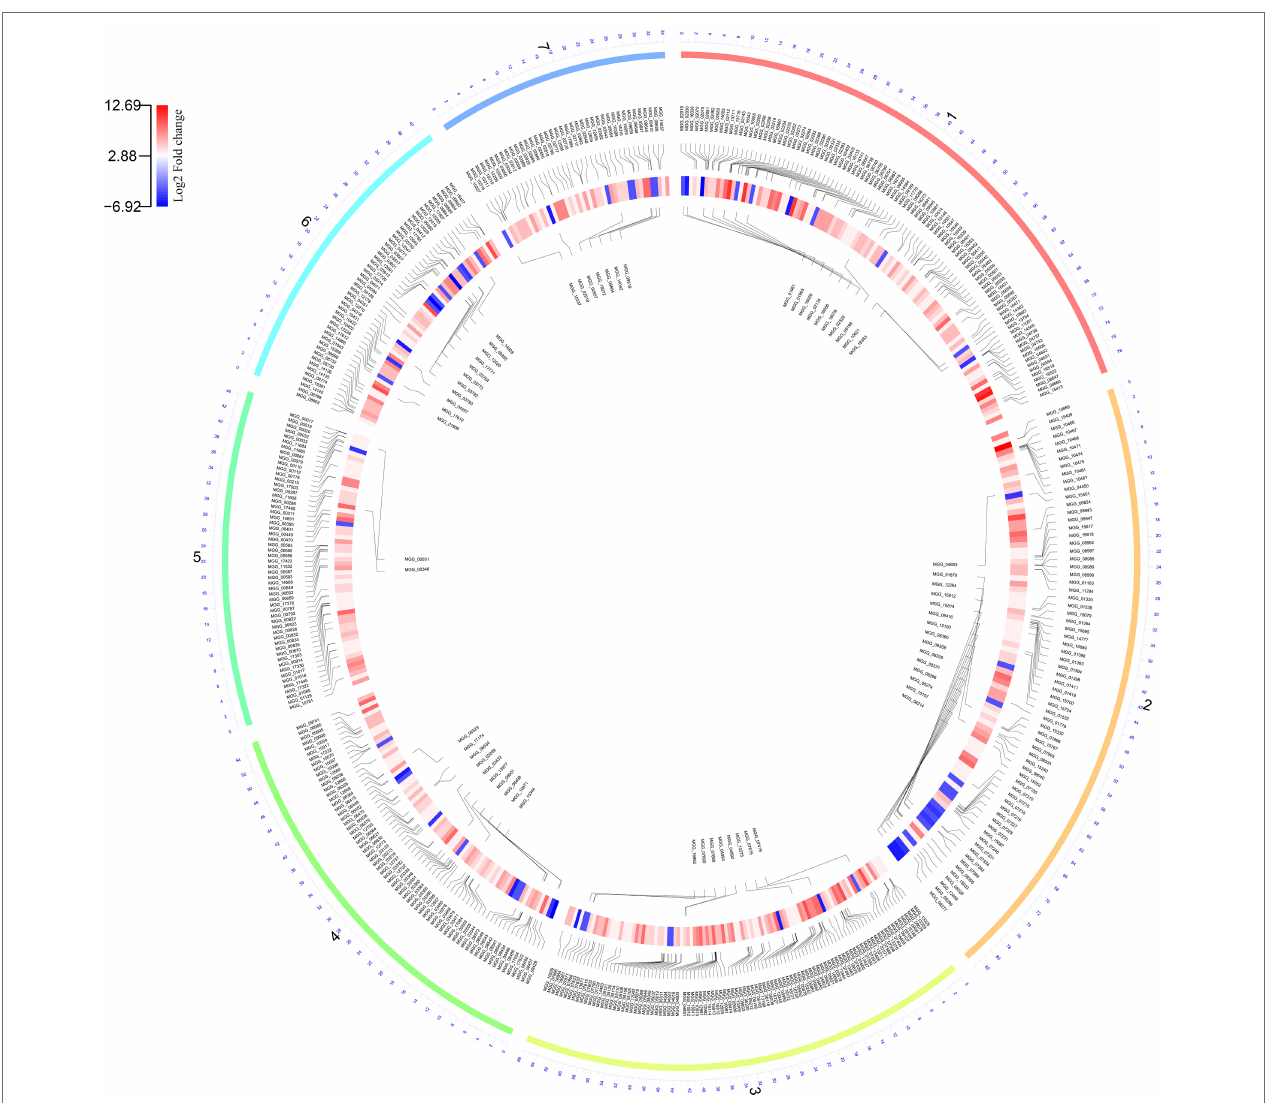
FIGURE 3 | The Circos plot shows the pattern of gene expression in fungi during the zinc oxide nanoparticle response. The outer layer shows seven fungal chromosome numbers. The inner layer and central layer show the upregulated and downregulated genes, respectively. The expression pattern is illustrated by a circular heatmap of differentially expressed genes